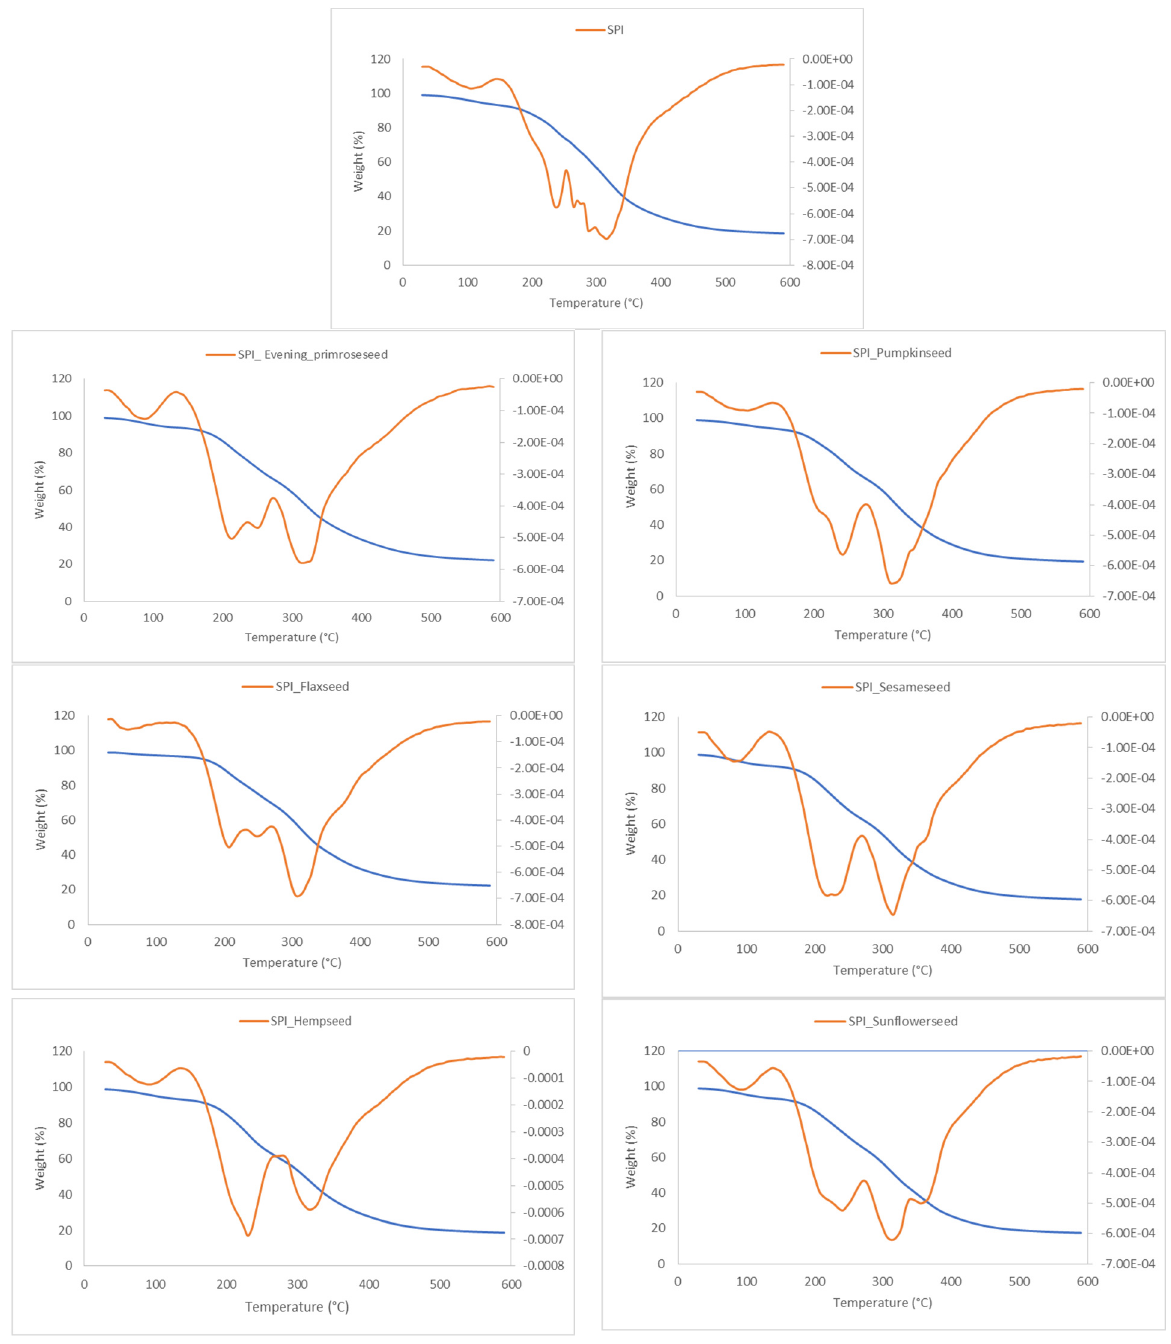
Figure 5. Thermogravimetric analysis (TGA) (blue) and derivative thermogravimetry (dTG) (orange) curves of films of soy protein isolate and oilseed flour.